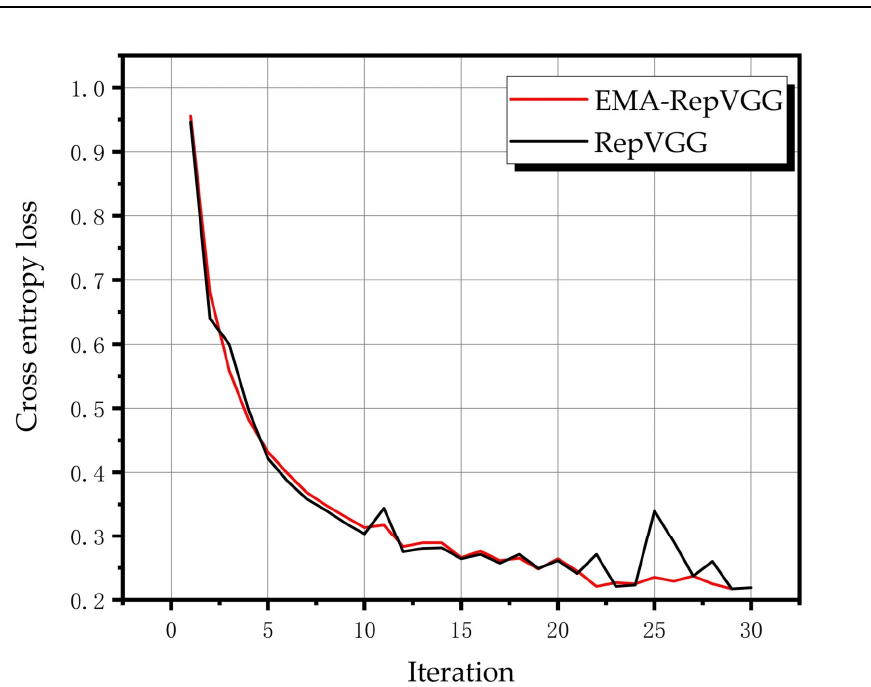
Figure 12. Loss functions.